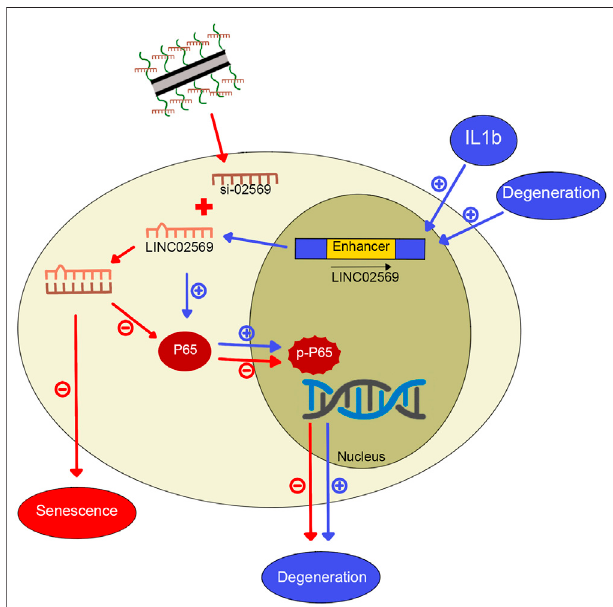
FIGURE 8 | Graphical abstract for IL1 β -induced LINC02569 promoted NPC degeneration through NF- κ B. 1) LINC02569 was upregulated in degenerative NP or IL-1 β -stimulated NPCs. LINC02569 promoted NF-kB activation, leadingtothedegeneration ofNPCs. (Seepathway consist of blue arrows. “ ＋ ” represents promoting). 2) Silencing LINC02569 with oCNT- pb-meditated siRNA inhibited P65 phosphorylation and prevented the transfer into the nucleus, resulting in attenuation of NP degeneration. Moreover, LINC02569 silencing leaded to alleviation of cell senescence. (See pathway consist of red arrows. “ − ” represents